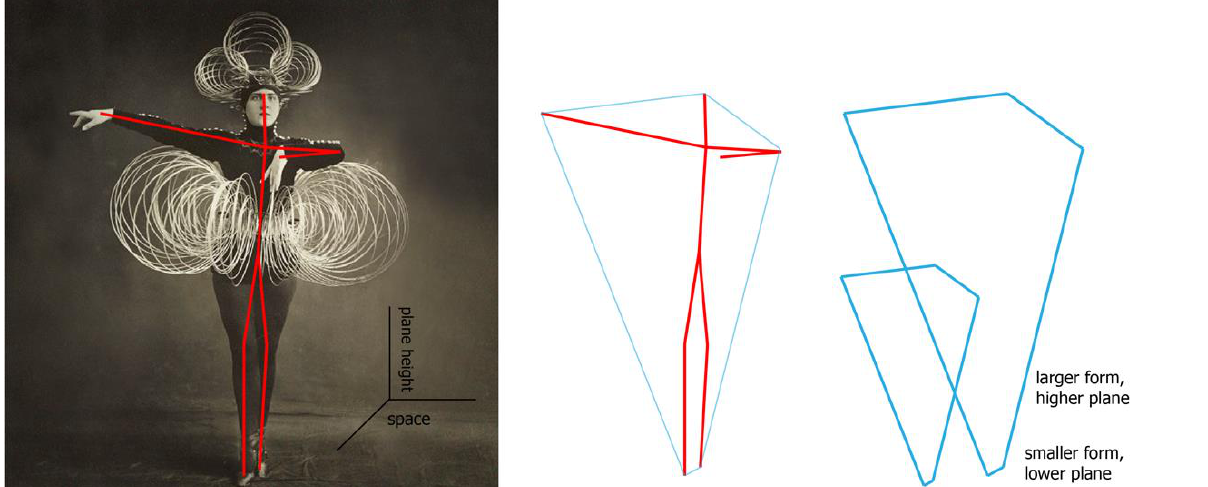
Figure 3 | Mapping human to form – or vice-versa – where size varies according to plane height (elevation). Source: Bauhaus costume by Oskar Schlemmer, Das Triadische Ballett, 1916 and